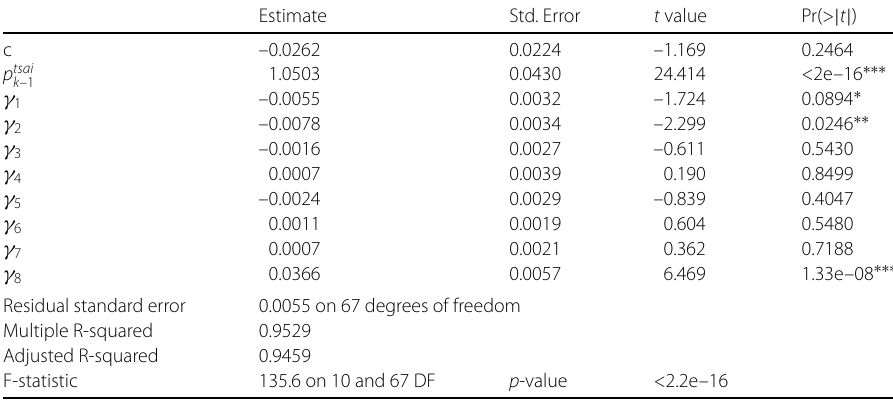
Table 2 Influential significance of events detected for Tsai